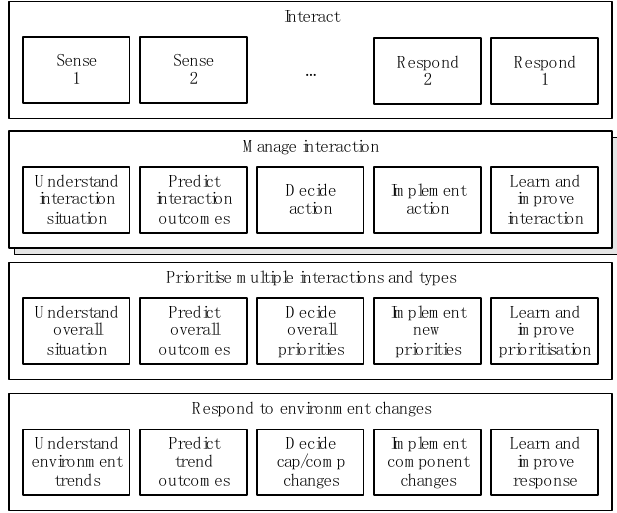
Figure 2. Information capability model.